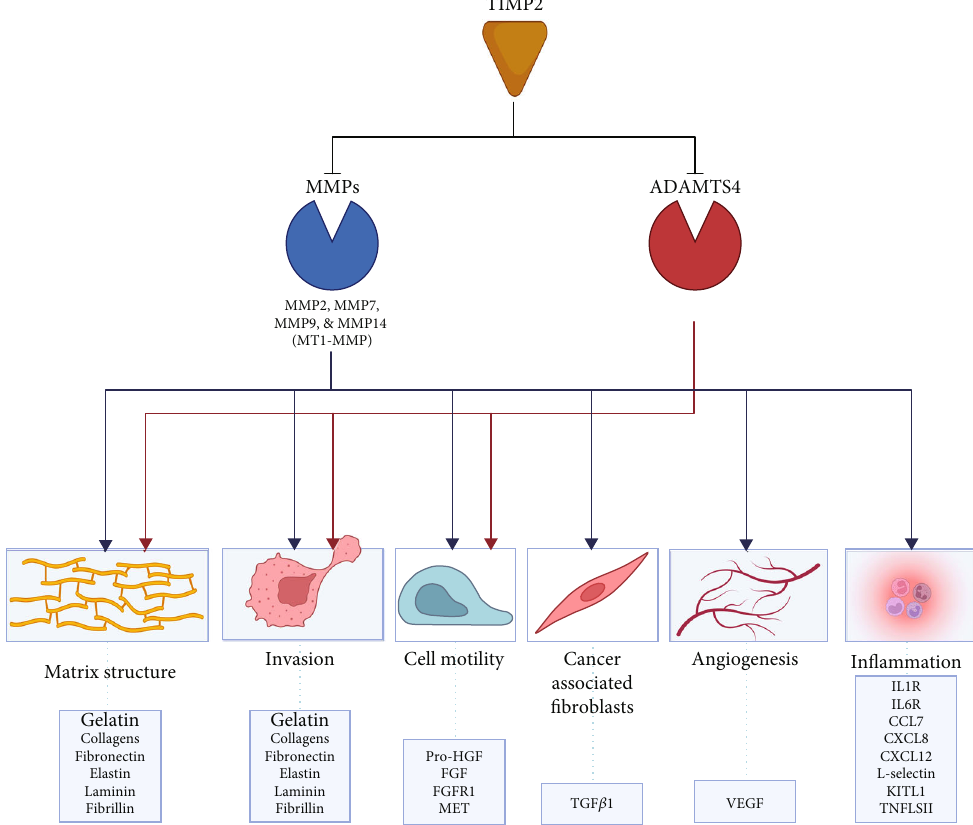
Figure 1: The primary established functions of TIMP2. TIMP2 inhibits several MMPs that cleave a range of substrates that impact structural and cellular aspects of tissue architecture. MMPs, membrane type 1 matrix metalloproteinase (MT1-MMP, also known as MMP-14), and ADAMTS break down ECM and structural proteins during cell invasion, motility, and tumor progression. Through proteolytic functions, TIMP2 a ff ects a vast range of cellular processes in cells and the lung microenvironment. ADAMTS: a disintegrin and metalloproteinase with thrombospondin domains; CCL: CC-chemokine ligand; CXCL: CXC-chemokine ligand; FGF: fi broblast growth factor; FGFR1: FGF receptor 1; IL-1R: interleukin-1 receptor; KITL: KIT ligand; pro-HGF: prohepatocyte growth factor; TGF: transforming growth factor; TNF: tumor necrosis factor; TNFR: TNF receptor; TNFLS11: tumor necrosis factor ligand superfamily member 11; VEGF: vascular endothelial growth factor — created with